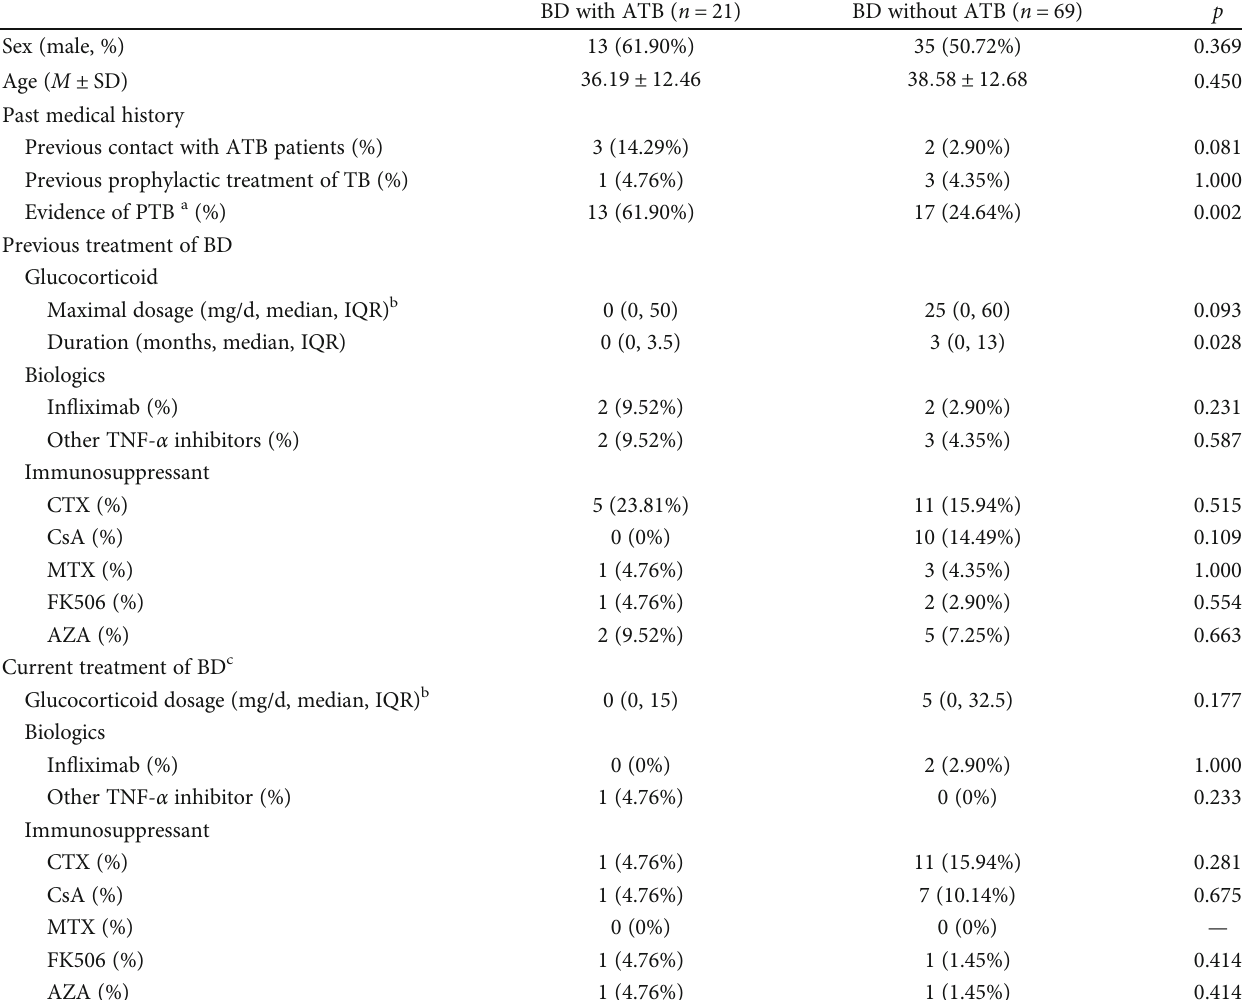
Table 1: Past medical history and medication of BD patients with and without